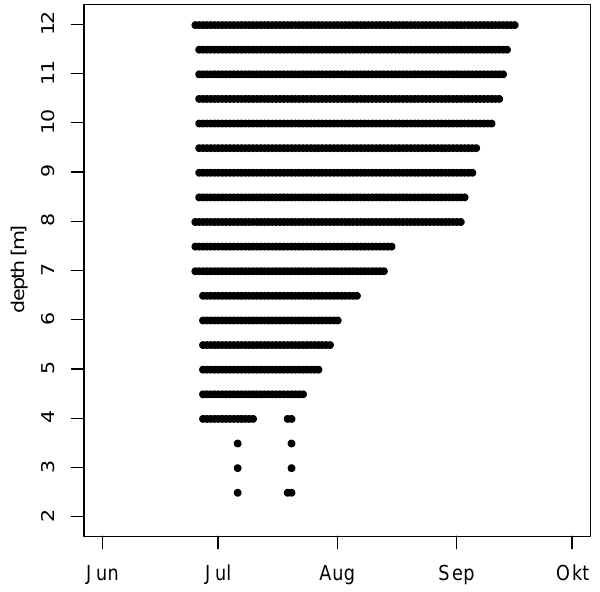
Figure 11. Summer stratification duration in lakes of varying depth (see Fig. 10 for